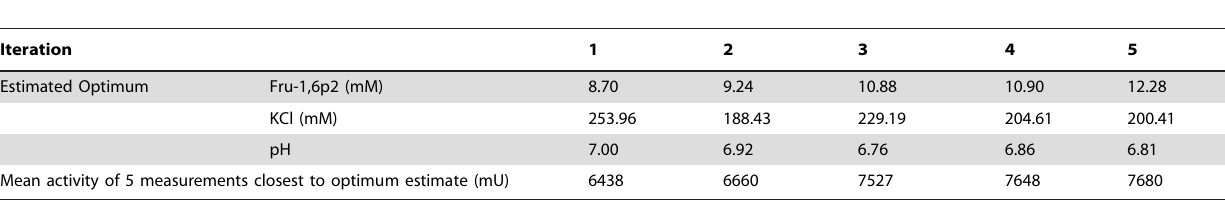
Table 1. Optimal condition estimates and average activity of the five measurements whose parameters are most similar to them over the five iterations.